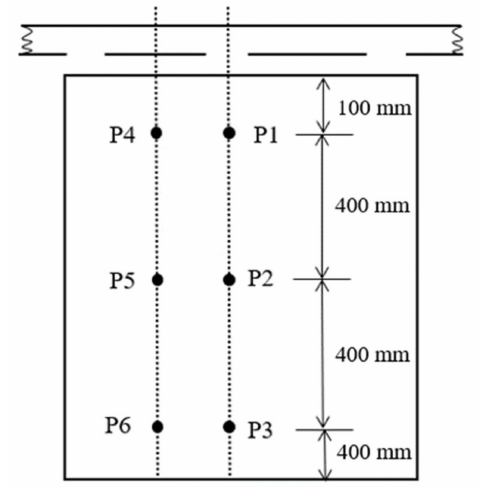
Figure 2. Setting of the six pressure monitoring points (P1, P2 and P3 locates positive-to-blow hole area; P4, P5 and P6 locates non-positive-to-blow